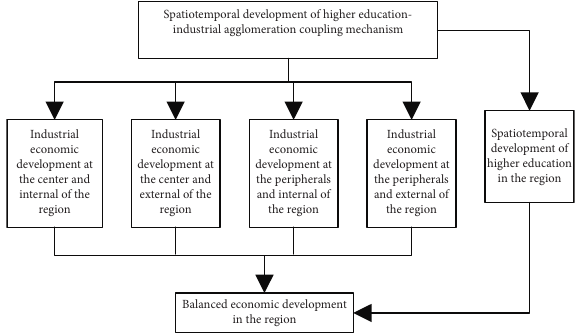
Figure 2: Principle of how industrial agglomeration coupling mechanism affects regional economic